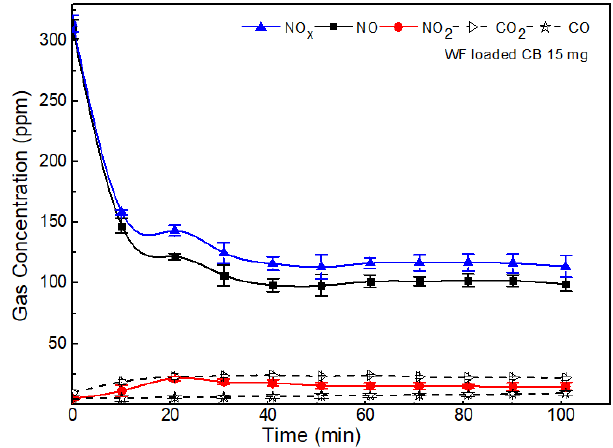
Figure 3. Effect of NO x removal in case of wood fiber loaded CB = 15 mg; applied voltage 7.5 kV and SED 50 J/L (error bars indicate the standard deviation).